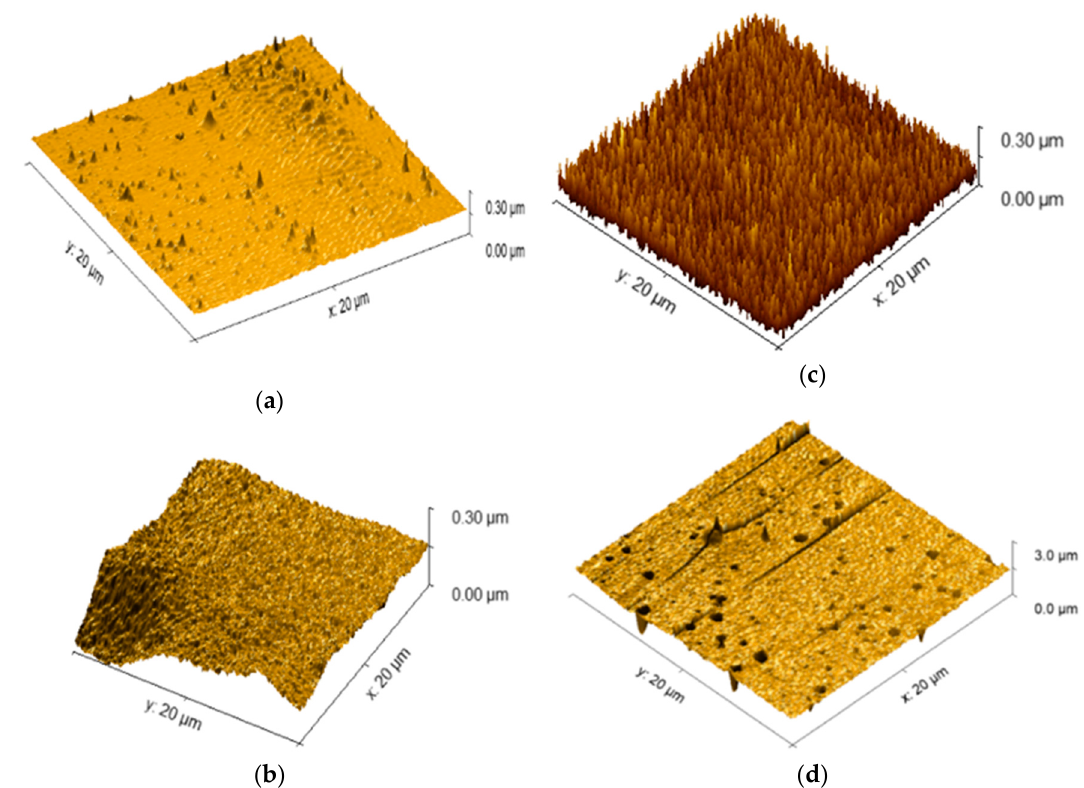
Figure 4. Surface topology of COC substrates using AFM; ( a ) untreated and plasma − treated for ( b ) 5 min, ( c ) 20 min, and ( d ) 120 min.